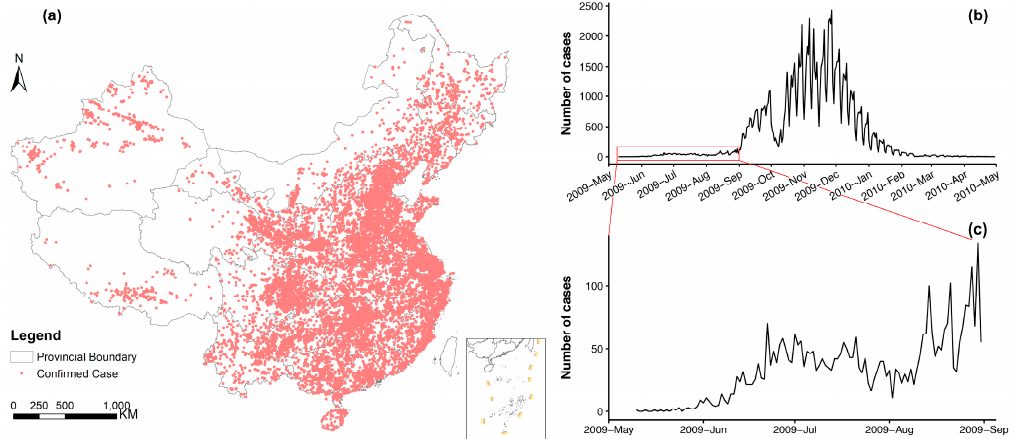
Figure 1. The spatial and temporal distribution of all 127,797 laboratory-confirmed